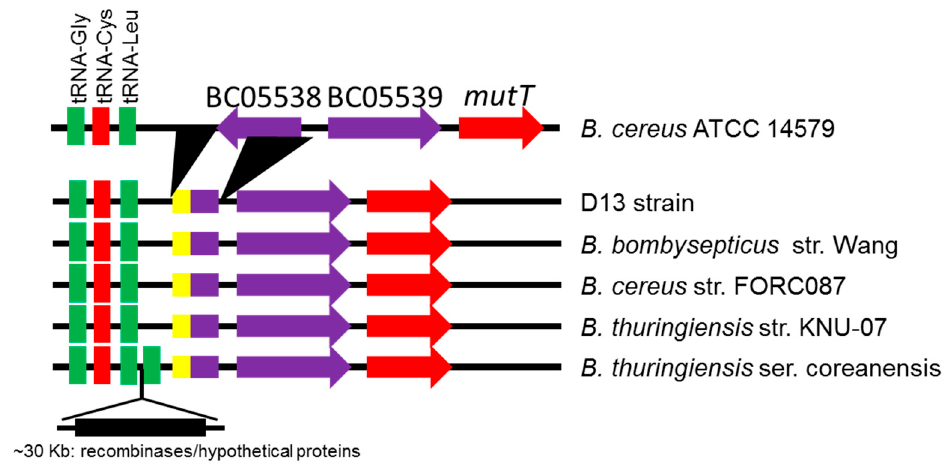
Figure 4 . Phylogenetic analysis in MEGA X, using the Neighbor-Joining method. tRNA Cys - yebC / pmpR genes sequences of the isolates were compared with sequences of B. cereus group obtained by BLAST search in the NCBI, GenBank database (http://www.ncbi.nlm.nih.gov) and representative strains were selected for the analysis. The bootstrap consensus tree inferred from 1000 replicates is taken to represent the evolutionary history of the taxa analyzed. Branches corresponding to partitions reproduced in less than 50% of the bootstrap replicates are collapsed. Group I contained almost exclusively species that were closely related to B. anthracis , while groups II, III, and IV contained species phylogenetically related to B. cereus and B. thuringiensis . The isolated colonies obtained are shown as D8 1517, D9 1517, D10 1517, D12 1517, D13 1517, and D14 1517 appearing within groups III and IV.